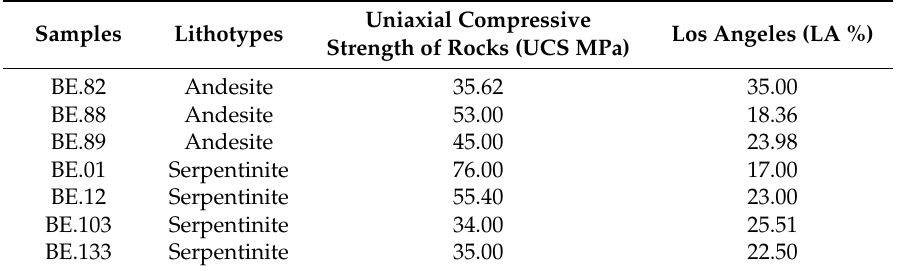
Table 1. Results of mechanical properties of the studied aggregates (each uniaxial compressive strength (UCS) value is the mean from six